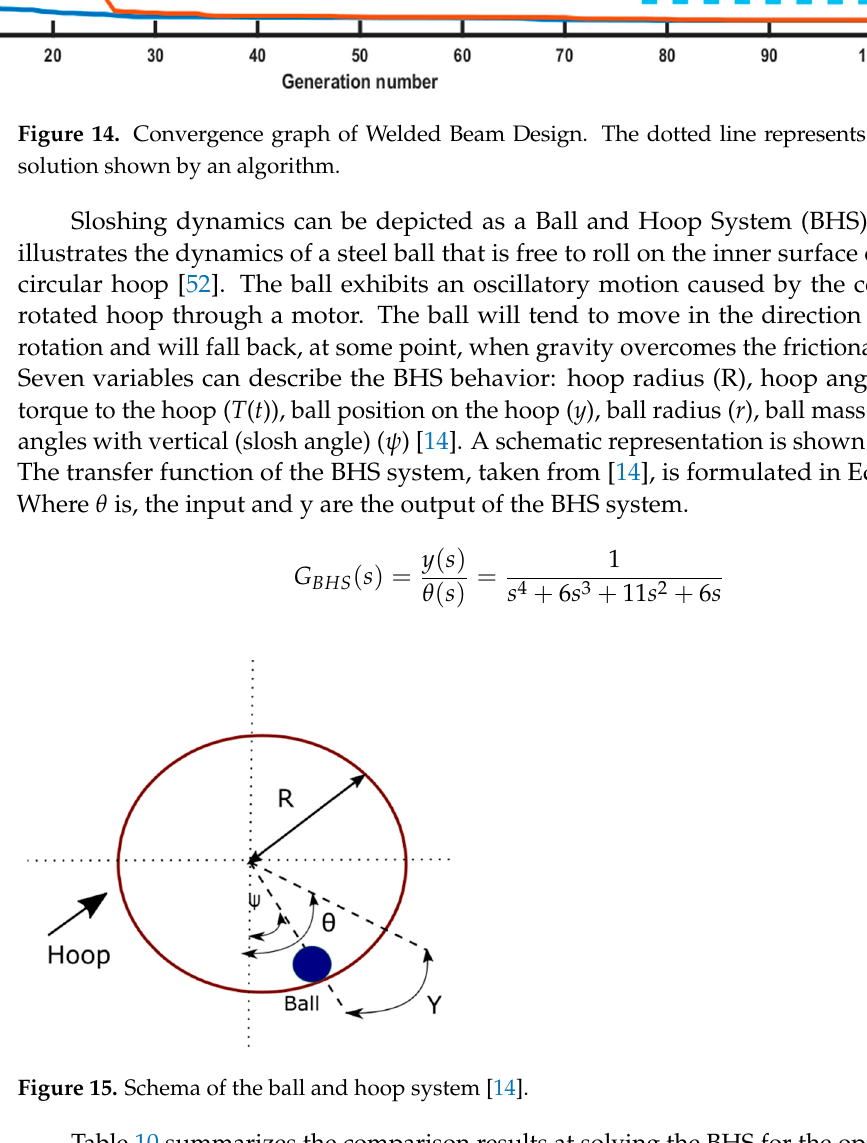
Figure 14. Convergence graph of Welded Beam Design. The dotted line represents an infeasible solution shown by an algorithm.